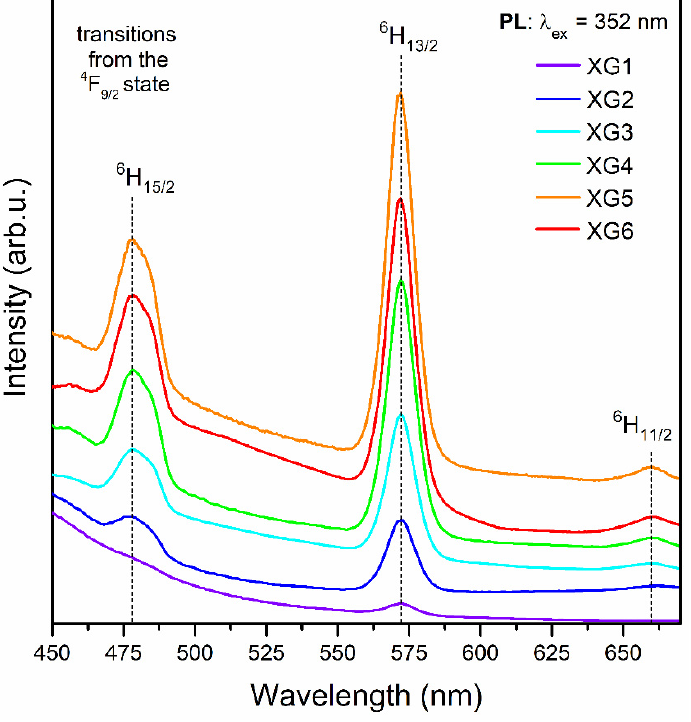
Figure 4. The photoluminescence emission (PL) spectra recorded for the series of prepared xerogels upon near-UV excitation at λ em = 352 nm.